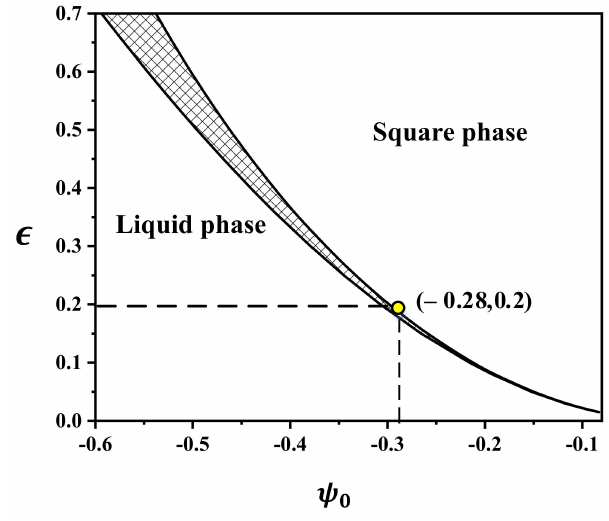
Figure 1. Two-dimensional phase diagram of two-mode approximate calculation; the area of the middle grid is a two-phases coexistence region.